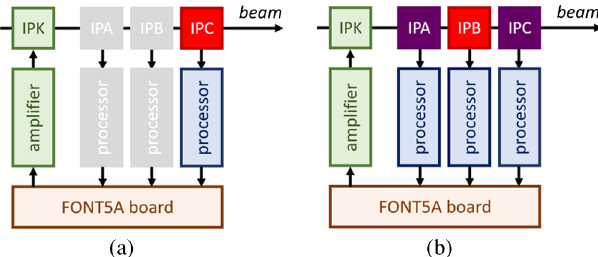
FIG. 12. Diagrams of feedback loops showing dipole cavity BPMs (IPA, IPB and IPC) and stripline kicker (IPK). (a) Single- BPM feedback with beam measurement and stabilization illus- trated at IPC (red). (b) Two-BPM feedback, illustrated for position measurements at IPA and IPC (purple) with beam stabilization at IPB